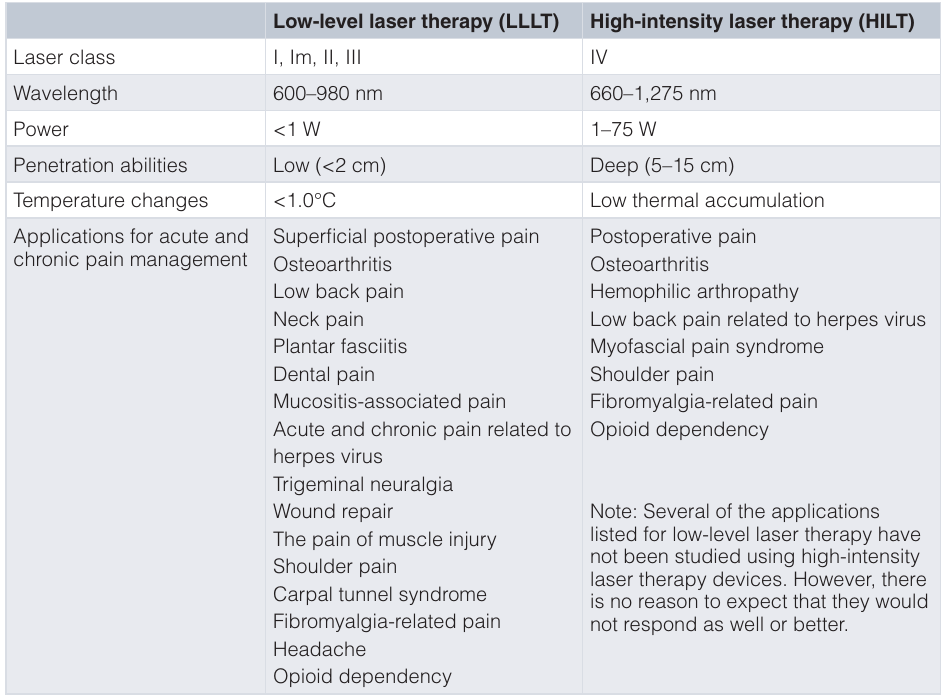
Table 2. Comparison of primary characteristics of low-level laser therapy and high-intensity laser therapy devices for the management of common pain